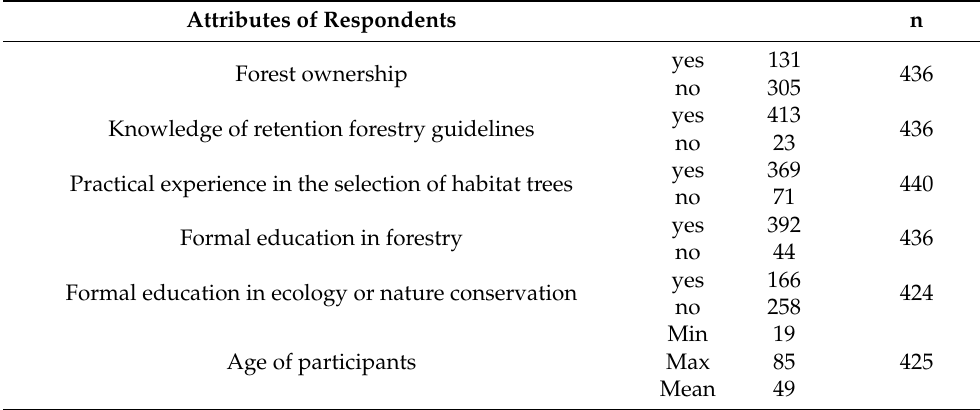
Table 1. Characteristics of